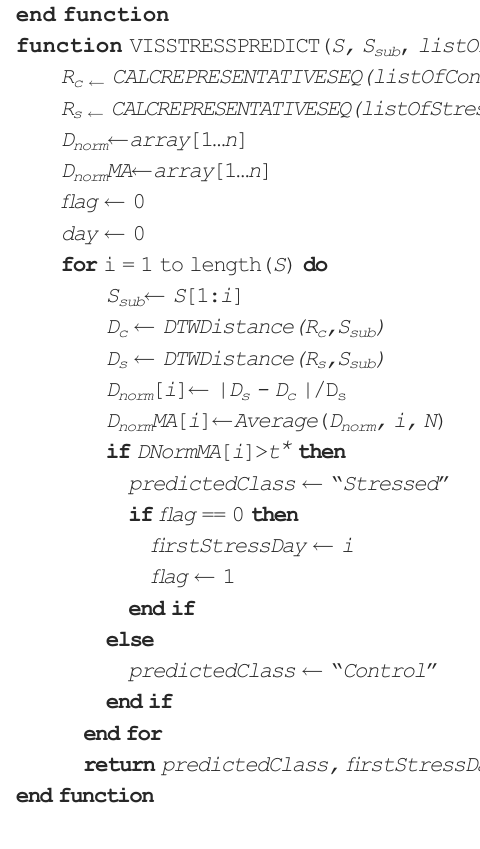
ALGORITHM 1 Classify control and stressed sequences and predict onset of